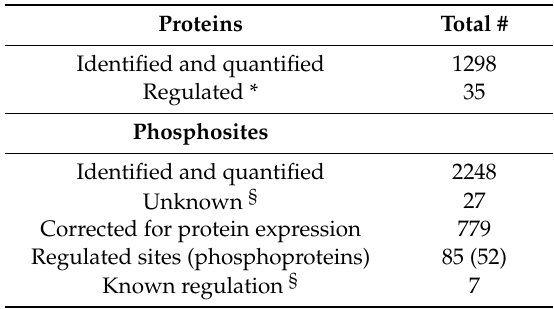
Figure 4. Workflow of proteomic and phosphoproteomic analysis.SILAC labeling with Arg-10 and Lys-8 was applied to KM12-UPF3A cells followed by treatment with doxycycline and mass spectrometric analysis leading to protein and phosphopeptide identification and quantification. Table 3. Summary of the proteome and phosphoproteome profiling upon UPF3A expression.